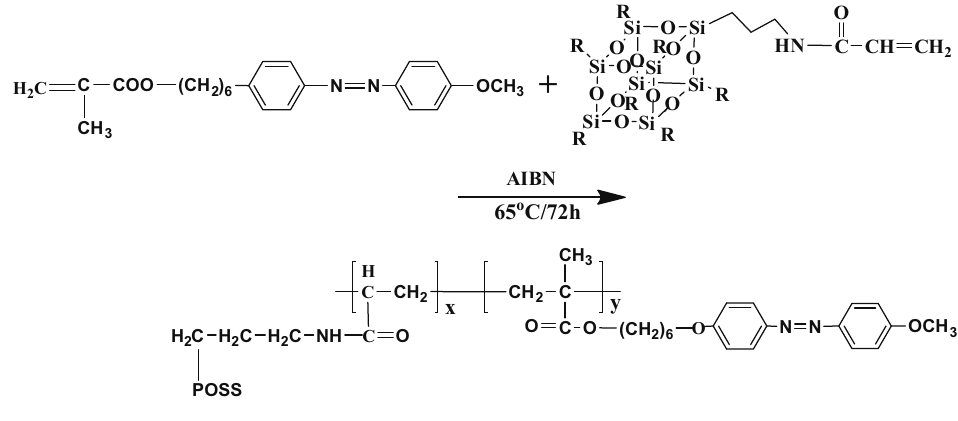
Figure 1: Synthesis of LCP -